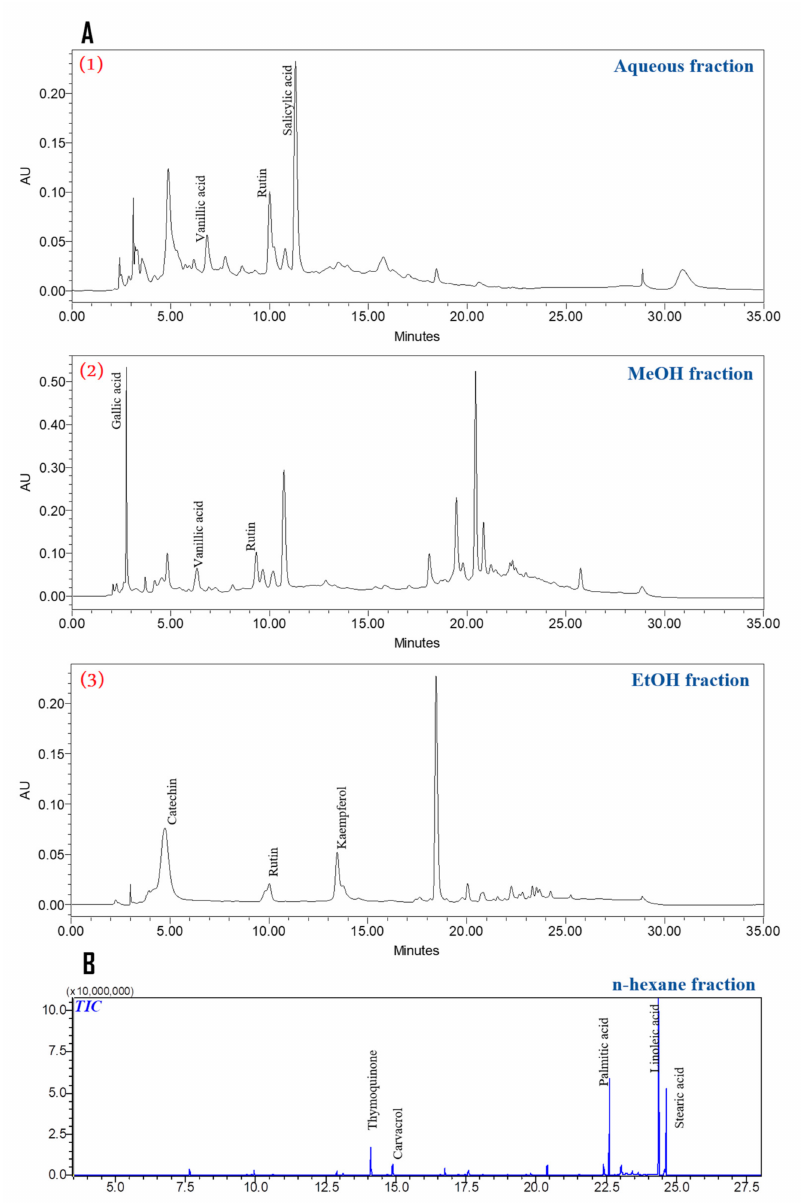
Figure 5. HPLC profiles of the different tested fractions ( A ) and the total ion chromatogram of the n-hexane fraction ( B ). (1) aqueous fraction, (2) methanol fraction and (3) ethanol